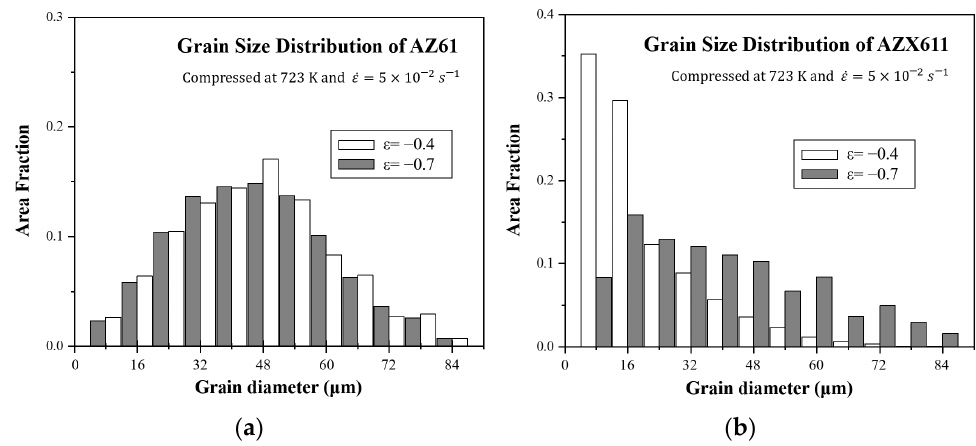
Figure 8. The graphs showing grain size distribution of ( a ) AZ61 and ( b ) AZX611 after each deformation condition.